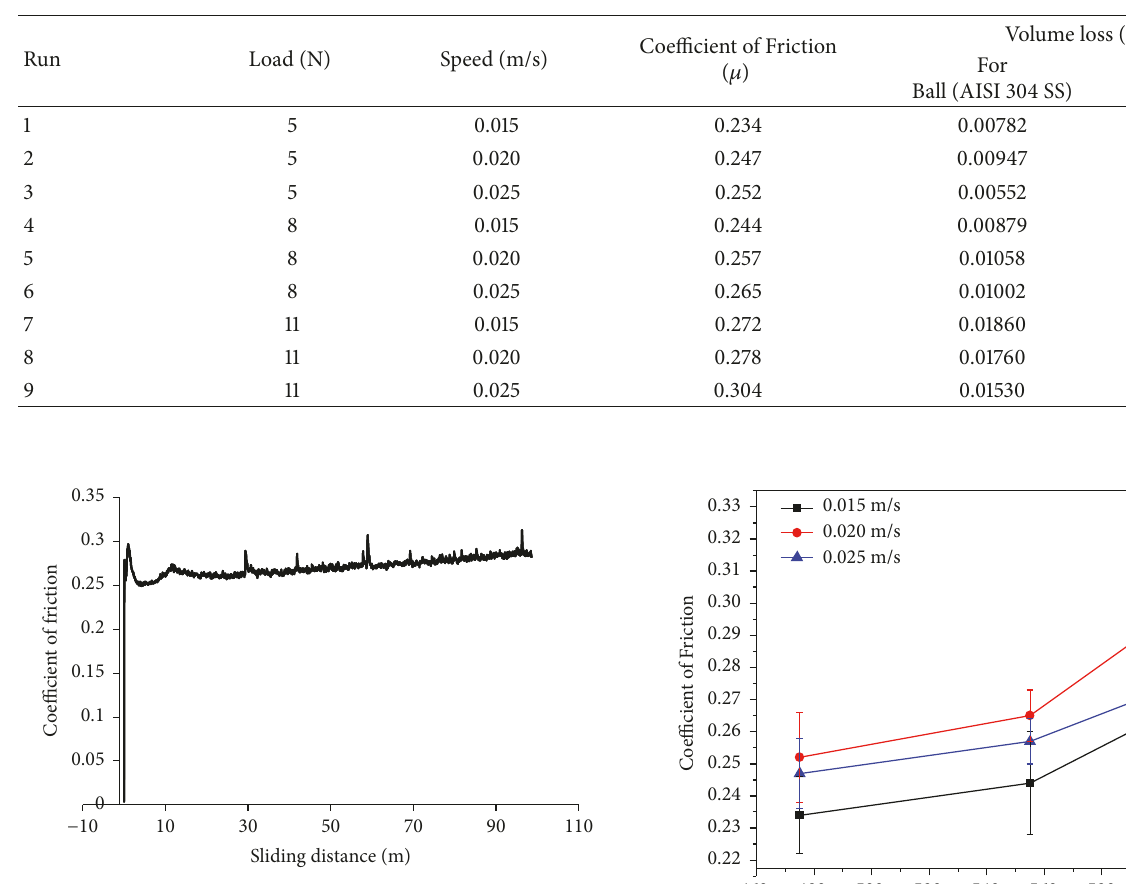
Table 3: Design layout and results for AISI 304 SS and Zr-4.